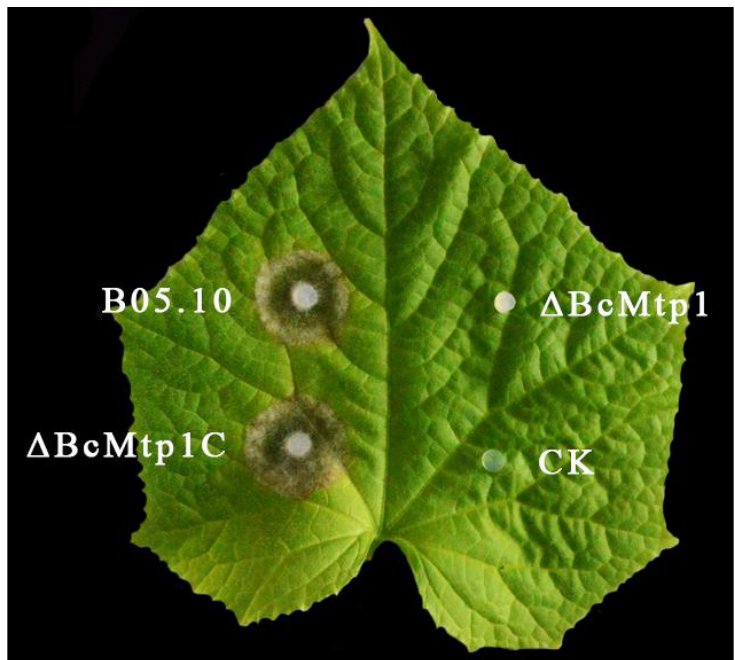
Figure 5. Pathogenicity assays on wounded cucumber leaves following inoculation with the wild- type B05.10 strain, the mutant ΔBcMtp1 , and the complemented strain ΔBcMtp1C . Agar plugs without fungal mycelia were used as negative controls (CK). Disease symptoms were analyzed 60 h post inoculation (h.p.i.).